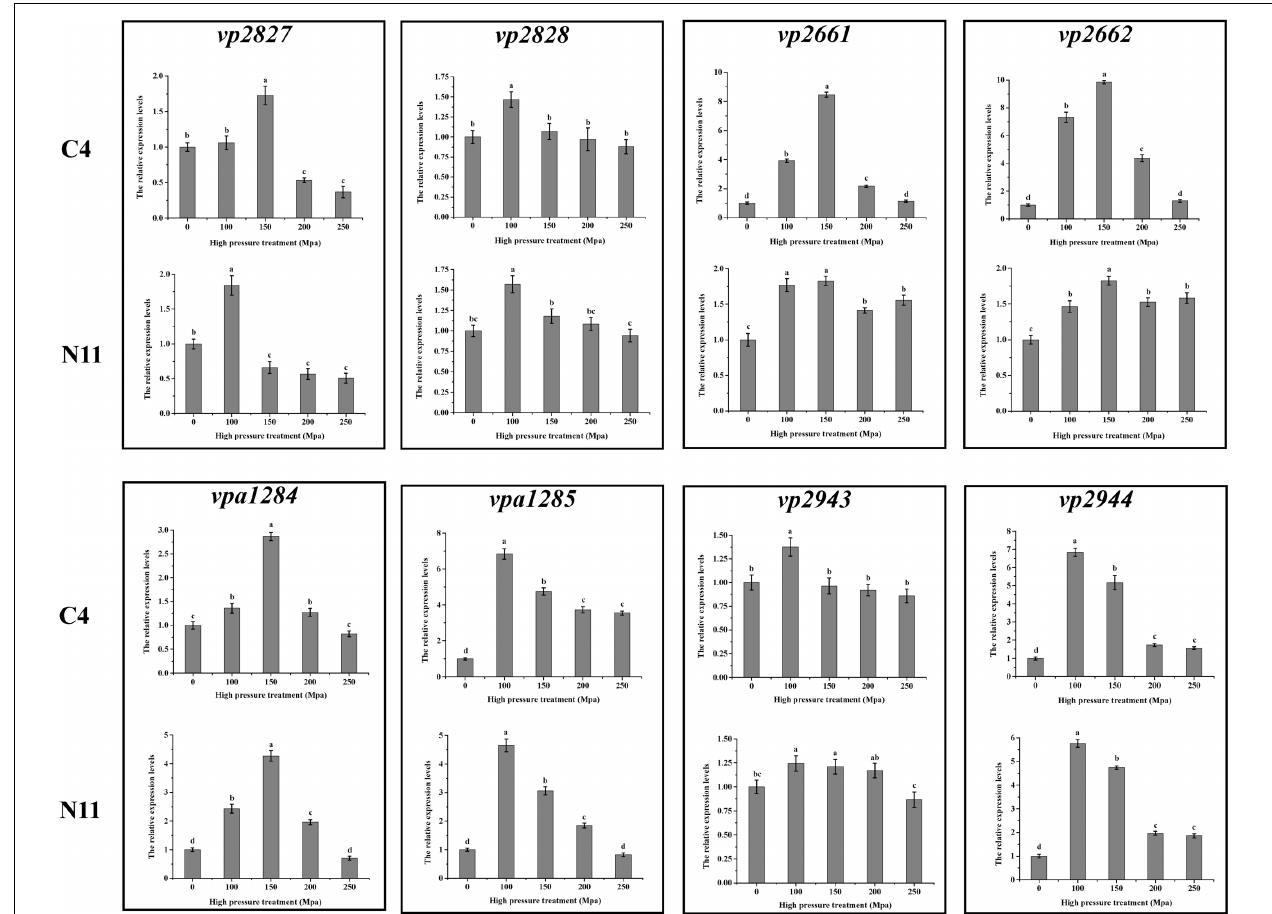
FIGURE 8 | Gene expression levels determined by